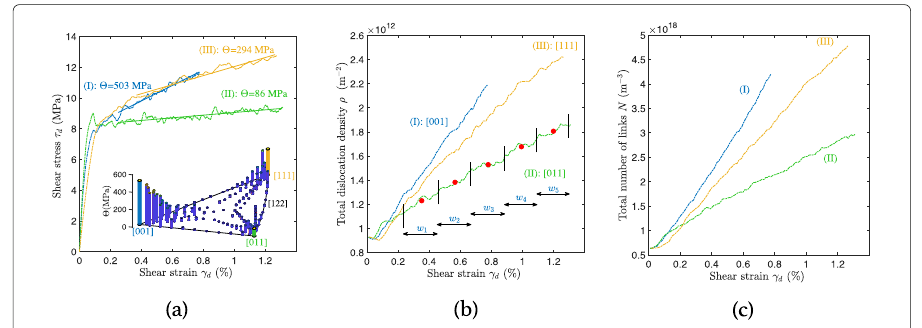
Fig. 2 a Shear stress-strain curves predicted by DDD simulations, along three high-symmetry loading orientations. Inset figure shows strain hardening rates from DDD simulations under constant strain rate ˙ ε = 10 3 s − 1 along 120 different loading directions. b Total dislocation density as a function of shear strain for the three loading orientations shown in (a). The windows of averaging, denoted by w r , r = 1,2, ... ,5 are illustrated on curve II and averaged values are shown by red dots. c Total number of link per unit volume for the three loading orientations shown in